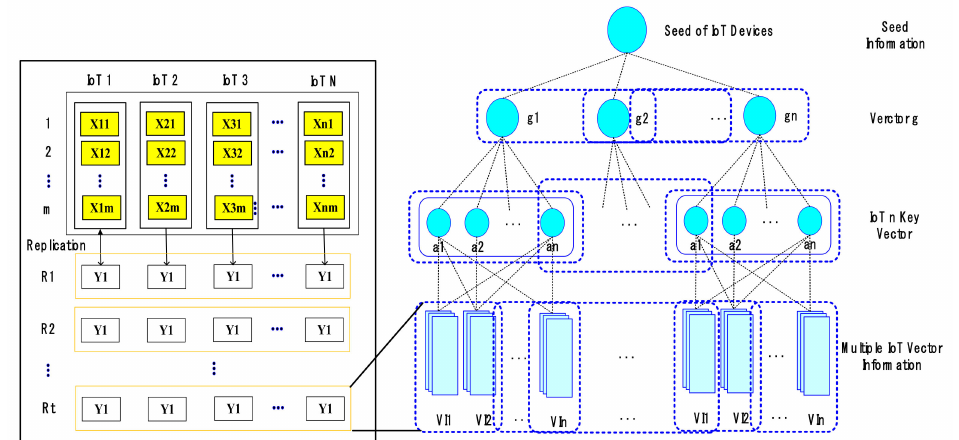
Figure 4. IoT block information grouped with multiple hash chains.